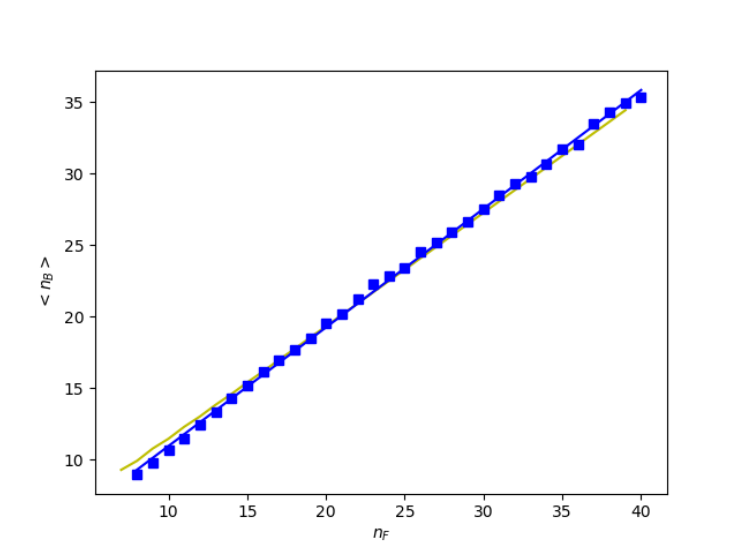
Figure 1: Forward-backward multiplicity of 7 TeV data. The squares represent the experimental data, the blue line represents the Linear Least Square fitting best fit line and the yellow line represents the foward-backward multiplicity as per the Chou-Yang model, using the GMD with k = 0 . 01 & k ′ = 1 . 85 with a cluster size of 2 .